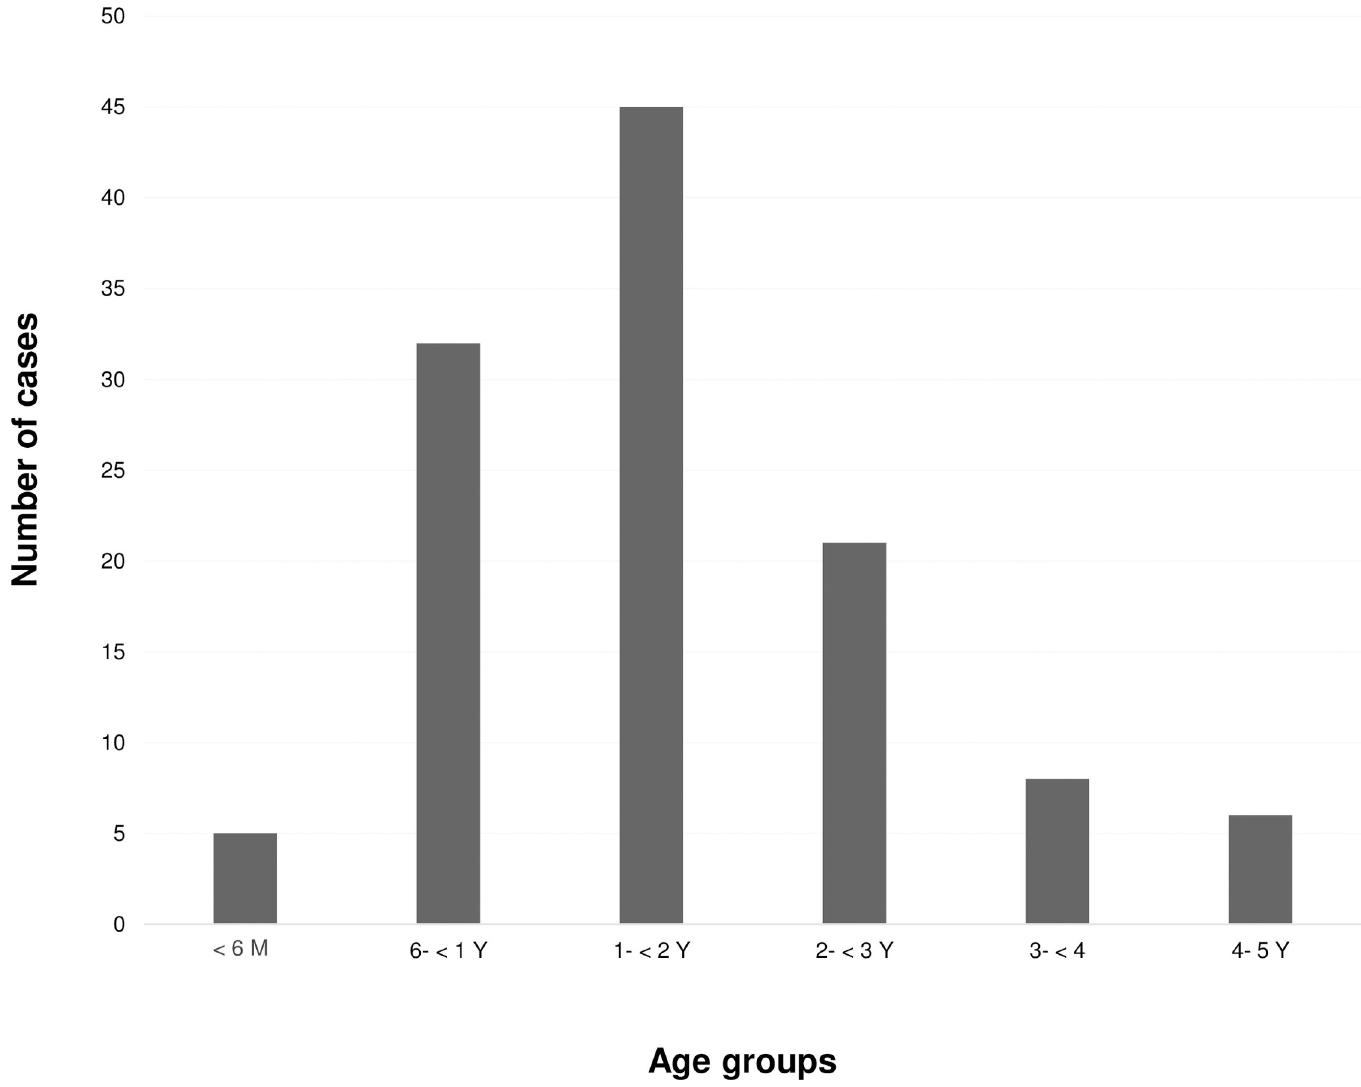
Fig 1. Detection of human adenovirus in different age groups of